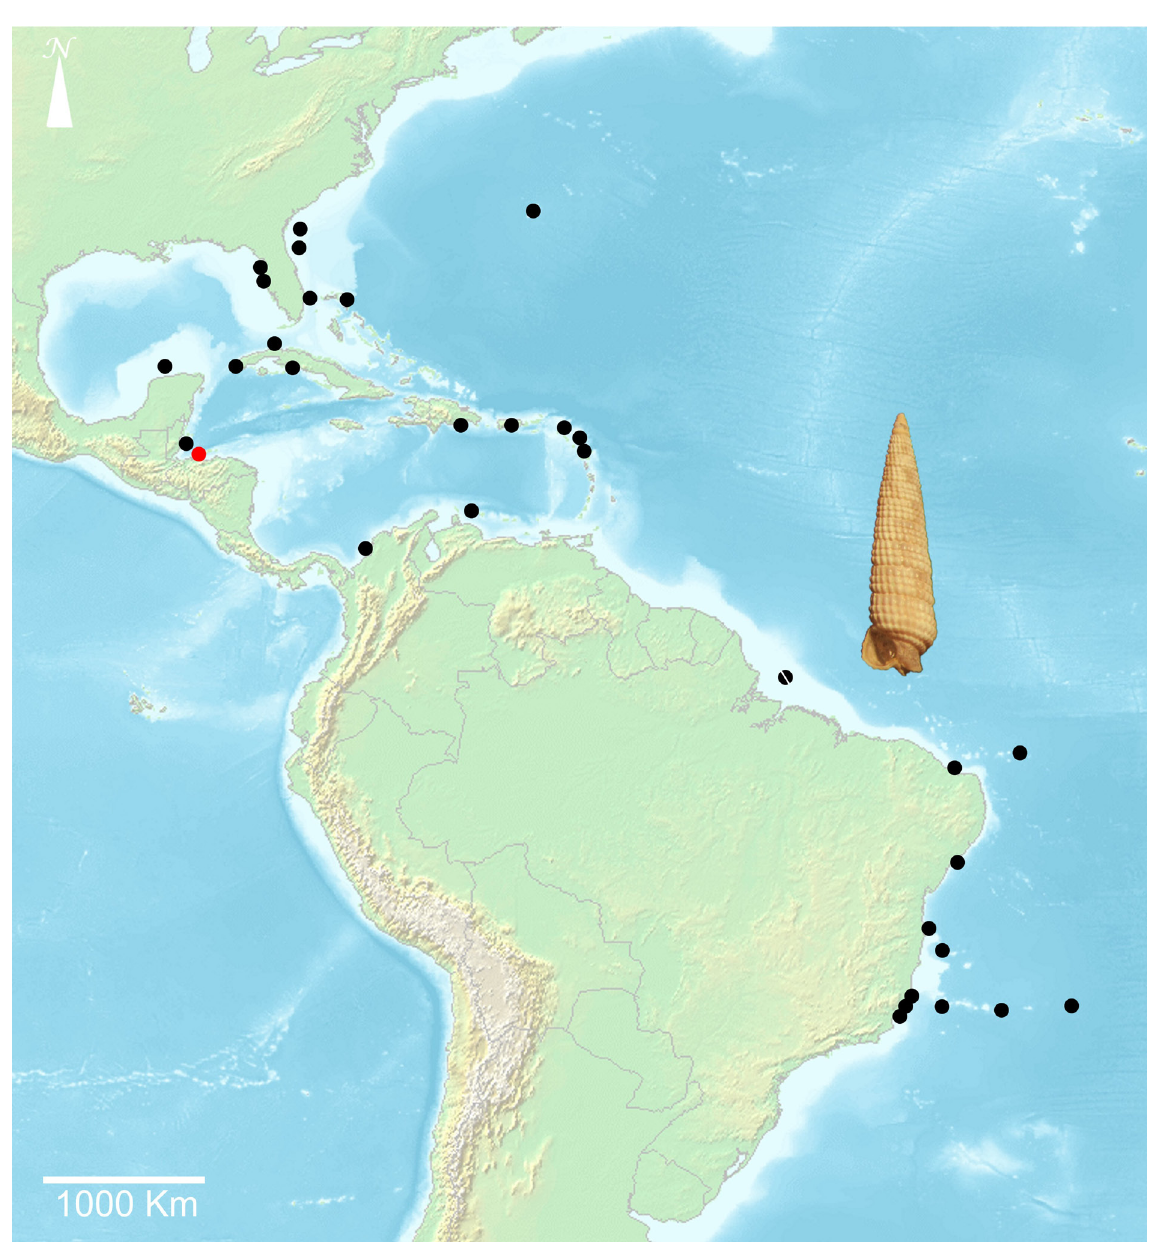
Fig. 53. Distribution map of Latitriphora albida (A. Adams, 1854); red circle = type